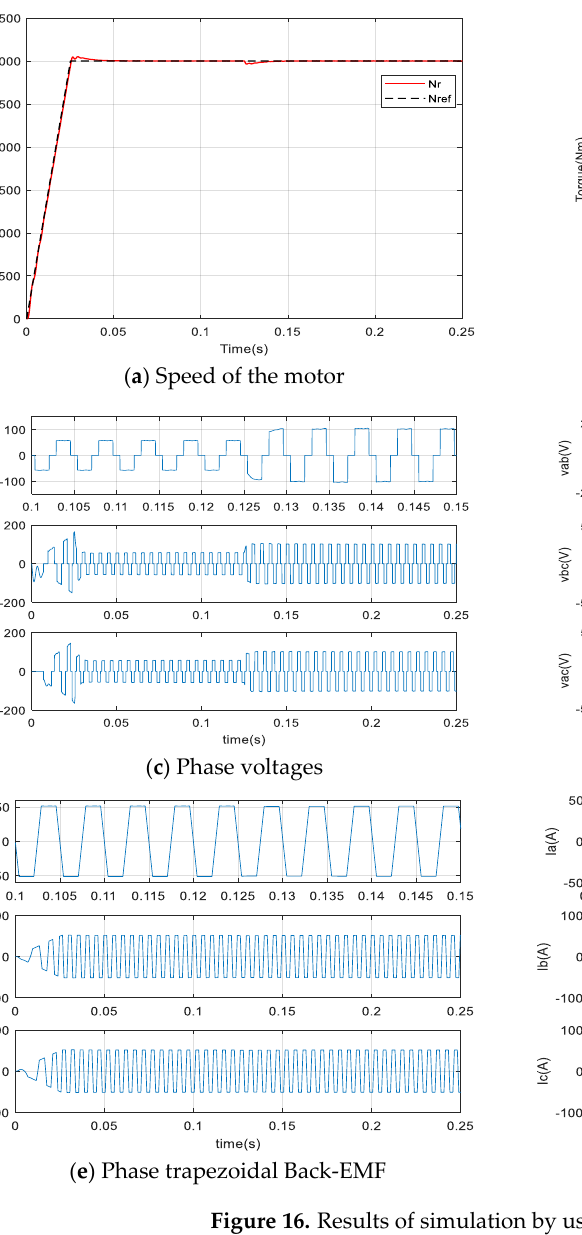
Figure 16. Results of simulation by using FFA_PI controller.